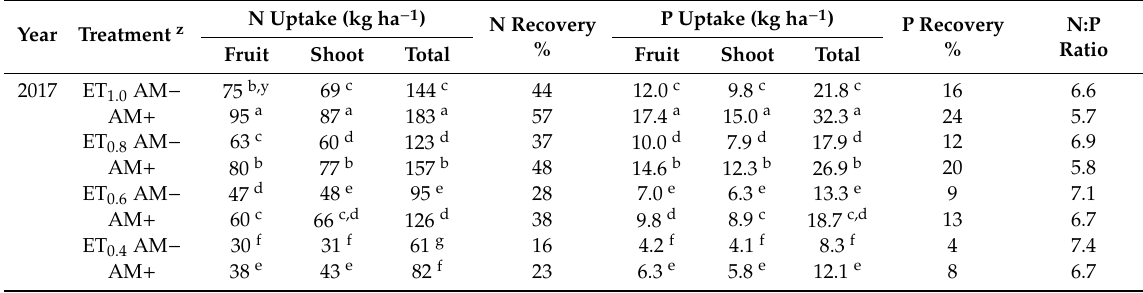
Table 4. Total N and P uptake in fruits and shoots of eggplant subjected to varying water stress and AM inoculation.